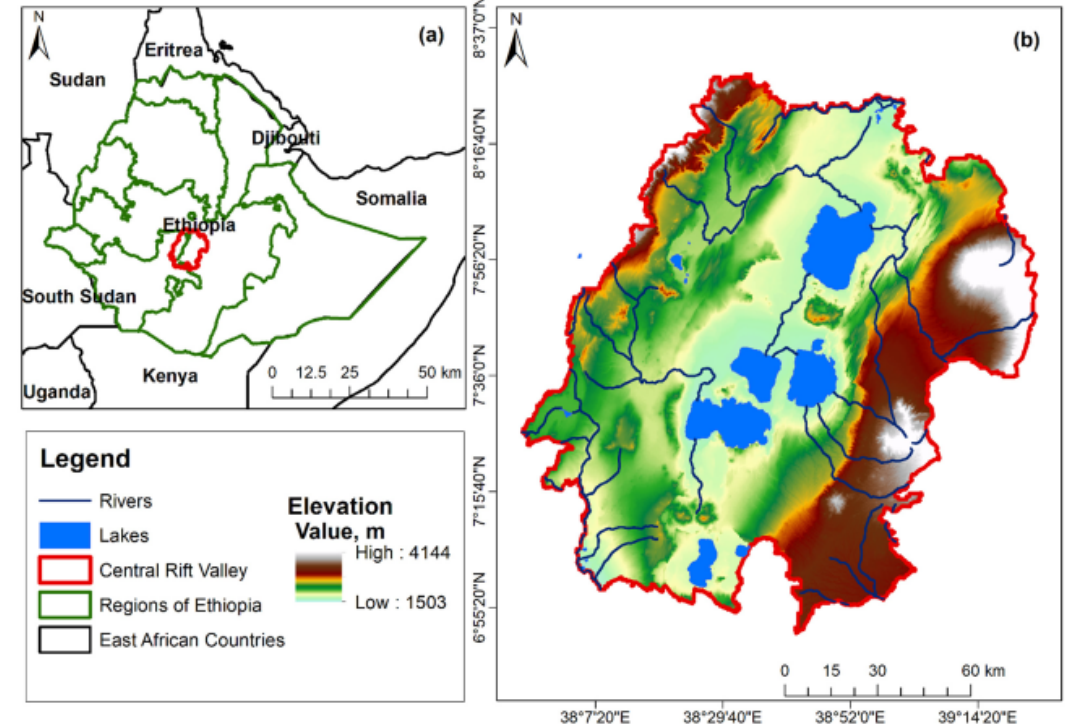
Figure 1. Geographical location of Ethiopia ( a ), and elevation variation and lakes in the Central Rift Valley (CRV), Ethiopia ( b